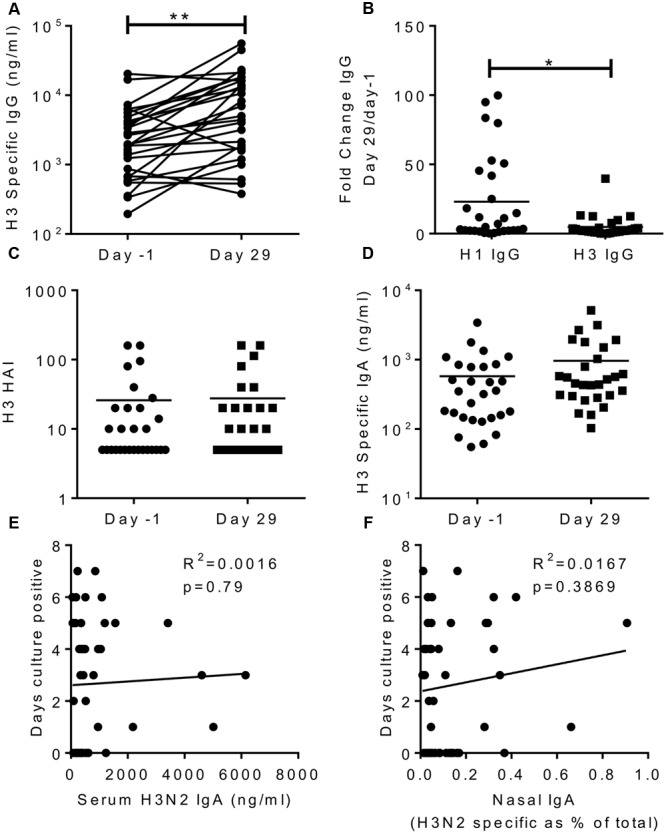
H3N2 specific antibody does not correlate with protection. H3N2 specific IgG (A), HAI (C) and IgA (D) were measured in serum on day-1 and day 29, fold change in IgG response compared between H1N1 and H3N2 IgG (B). Days culture positive virus was recoverable compared to H3N2 specific serum IgA (E) and nasal IgA (F). Data pooled from two studies, n = 47 volunteers.